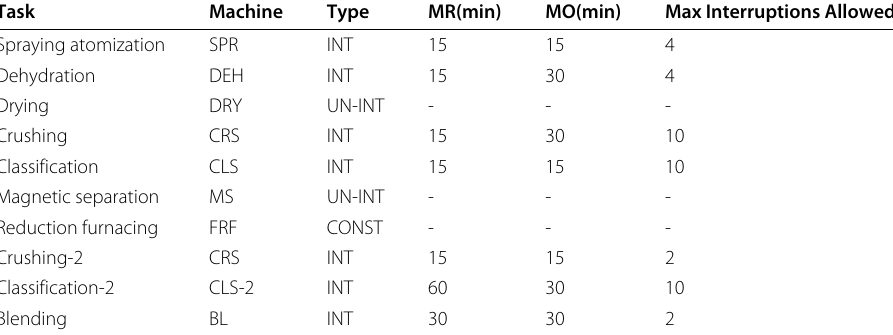
Table 6 Parameters for the tasks in MFS Task